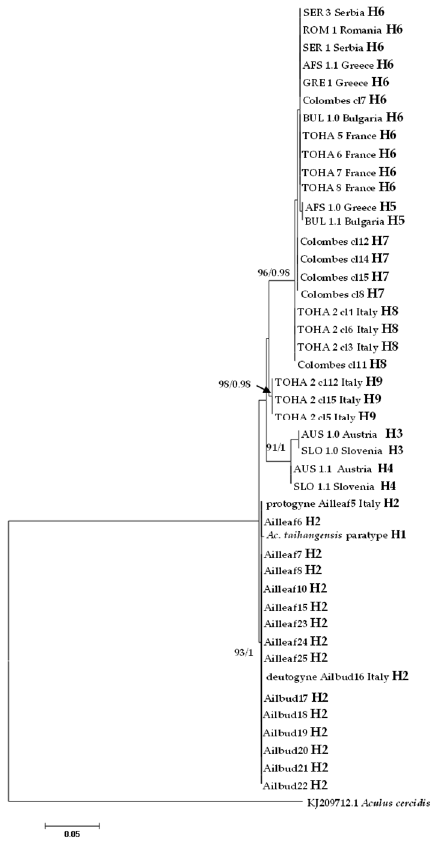
Figure 6. Maximum likelihood phylogenetic tree of Aculus mosoniensis ITS1 sequences, Aculops taihangensis, and one congener, Aculus cercidis, used as outgroup. Only significant values of bootstrap support (>90%) and of Bayesian posterior probabilities obtained by MrBayes (>0.9) are shown at the nodes. The scale bar indicates the expected number of substitutions per site. Tips labels refer to specimen IDs and haplotypes listed in Table 1.